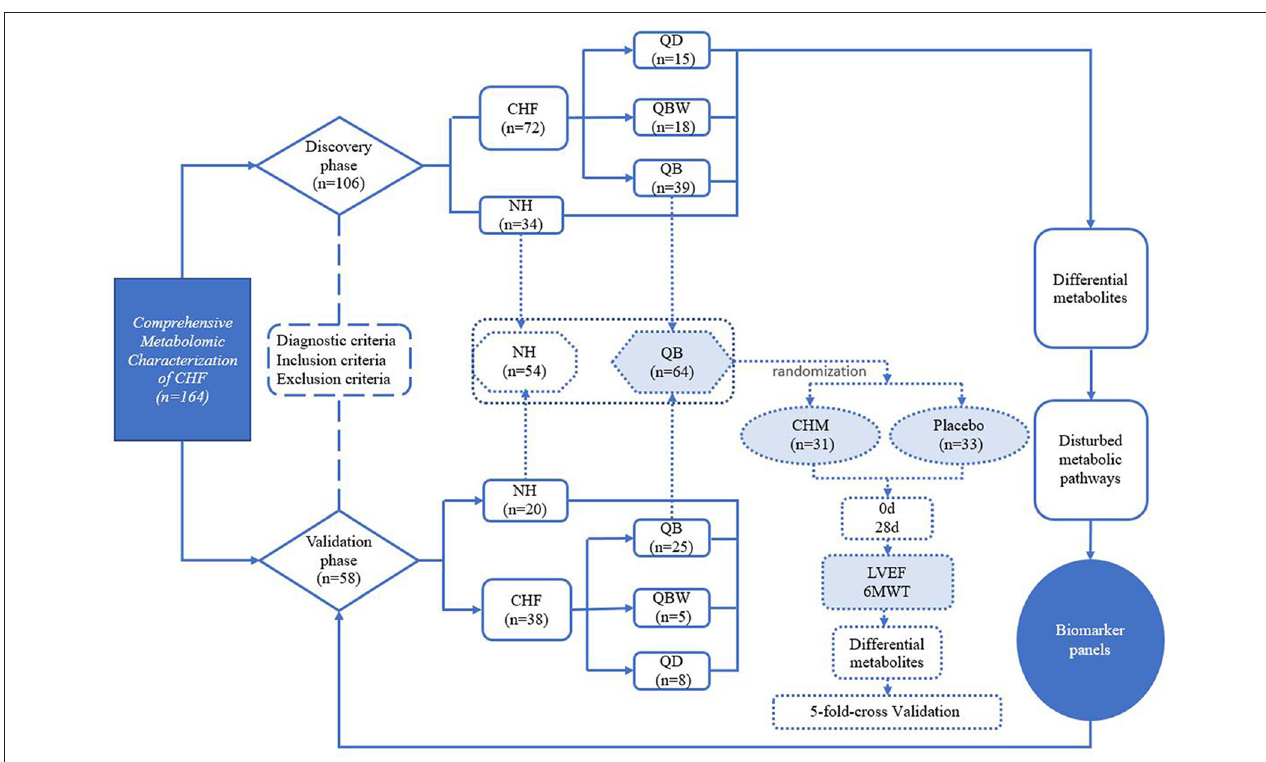
FIGURE 1 | Study Design. 6MWT, 6Min Walking Test; CHF, Chronic heart failure; CHM, Chinese herbal medicine; LVEF, Left Ventricular Ejection Fraction; NH, Normal healthy group; QD, Qi deficiency group; QB, Qi deficiency and Blood stasis group; QBW, Qi deficiency and Blood stasis and Water retention